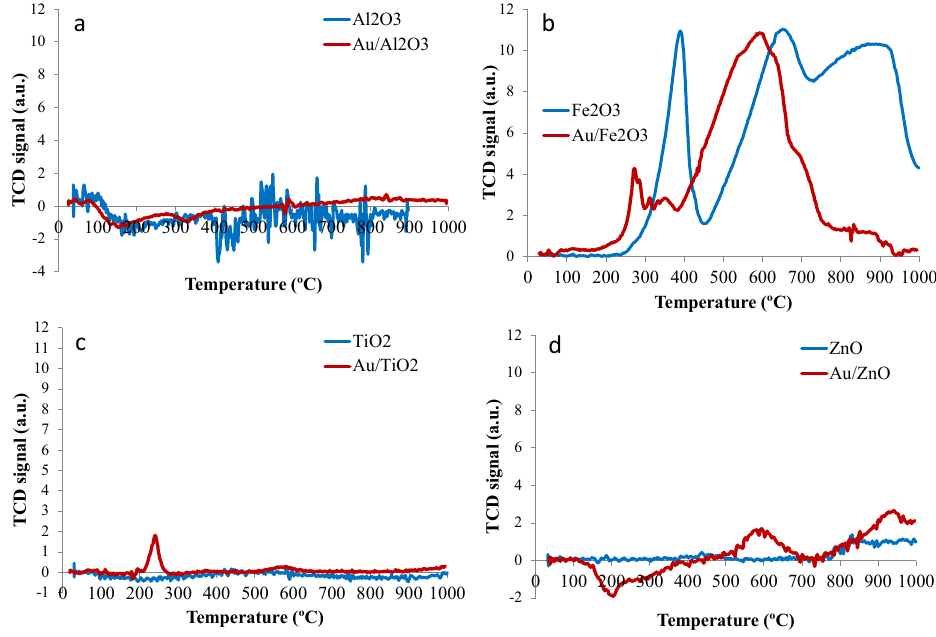
Figure 2. TPR profiles of supports and Au samples: ( a ) Al 2 O 3 , ( b ) Fe 2 O 3 , ( c ) TiO 2 , ( d ) ZnO. Adapted from [5] with permission from Wiley.